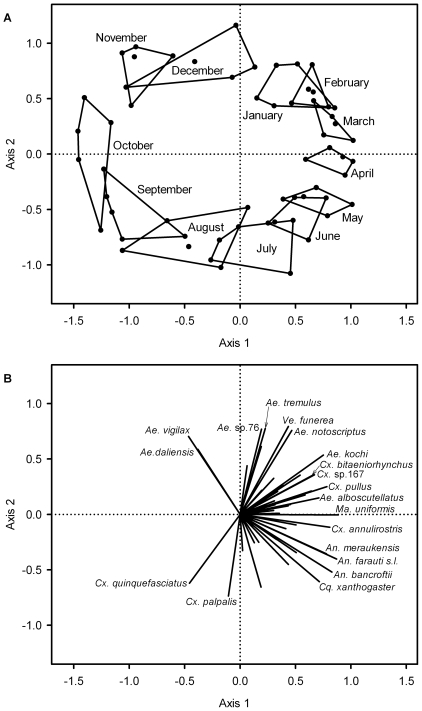
Ordination (A) and biplot (B) of mosquito samples.Based on the abundance of 43 species at 11 sites combined, with samples in common months (n = 5 years) linked to form convex polygons. (B) comprises significant (Bonferroni-corrected) biplot vectors for species (only those with r>0.7 are labelled). The length of vectors in (b) is relative to their r value, scaled to the axes coordinates. Ae. = Aedes; An. = Anopheles; Cq. = Coquillettidia; Cx. = Culex; Ma. = Mansonia; Ve. = Verrallina.